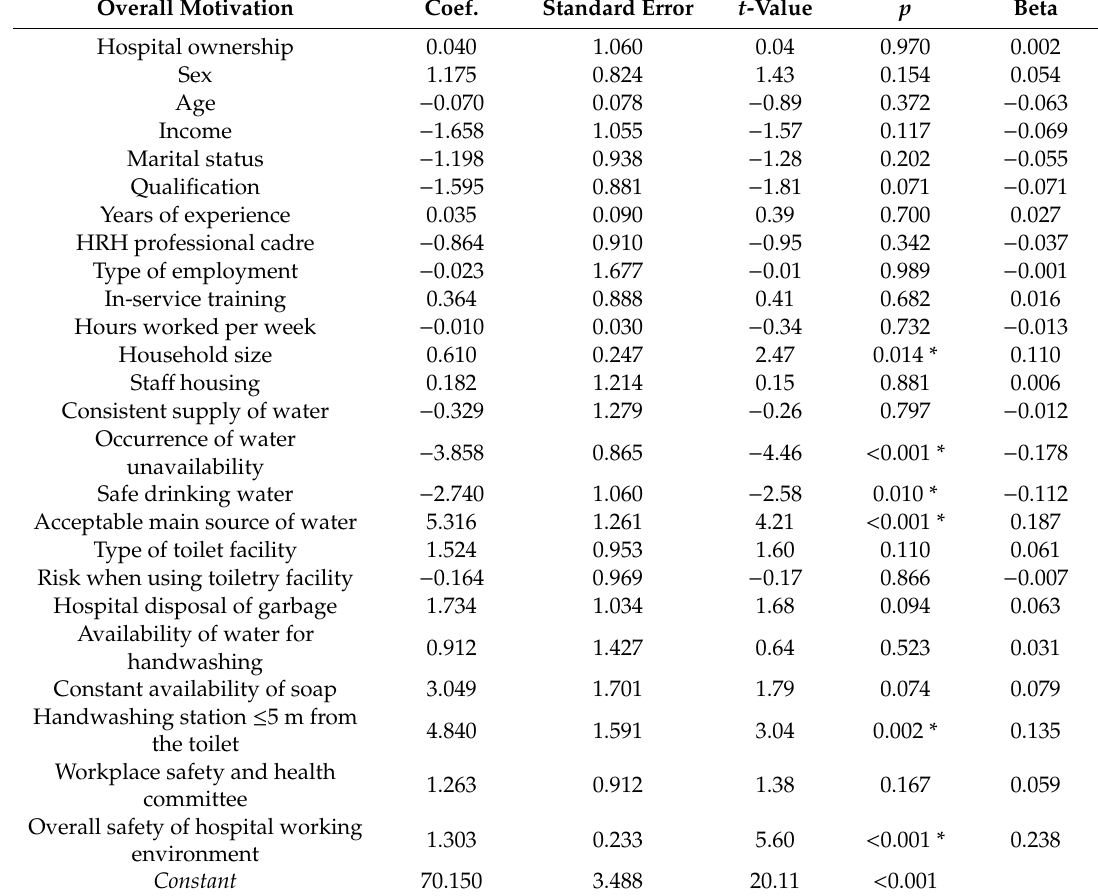
Table 6. Multivariate regression of overall motivation, sociodemographic, and work-environment factors ( n =